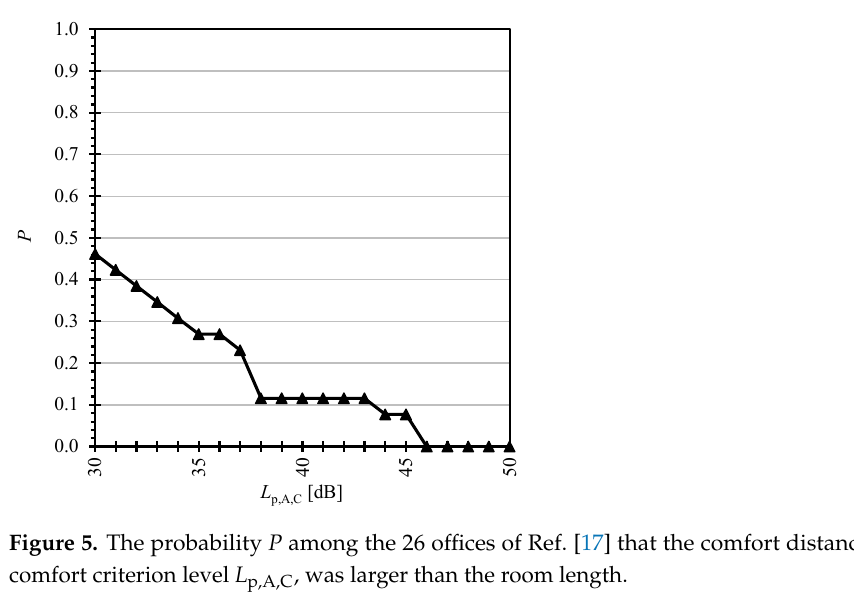
Figure 4. The range of comfort distance values, r C , as a function of the comfort criterion level, L p,A,C , for the 26 offices of Ref. [17] calculated by Equation (2). Mean, maximum, minimum, and 68% con- fidence interval (C.I.) within the sample of 26 offices are shown.